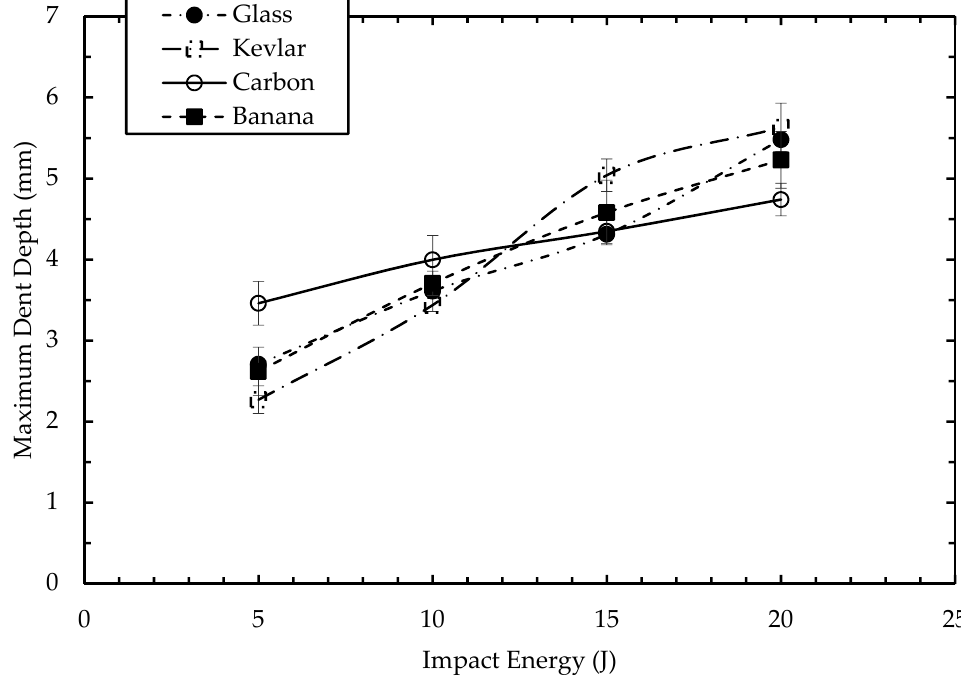
Figure 7. Variation of the maximum dent depth against energy level traces for composite structures.